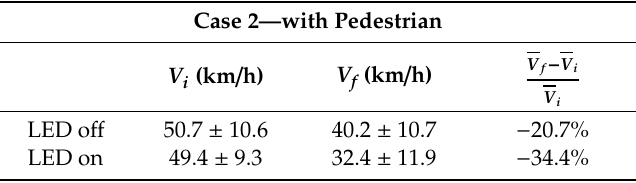
Table 2. Mean speed comparison (with pedestrian).